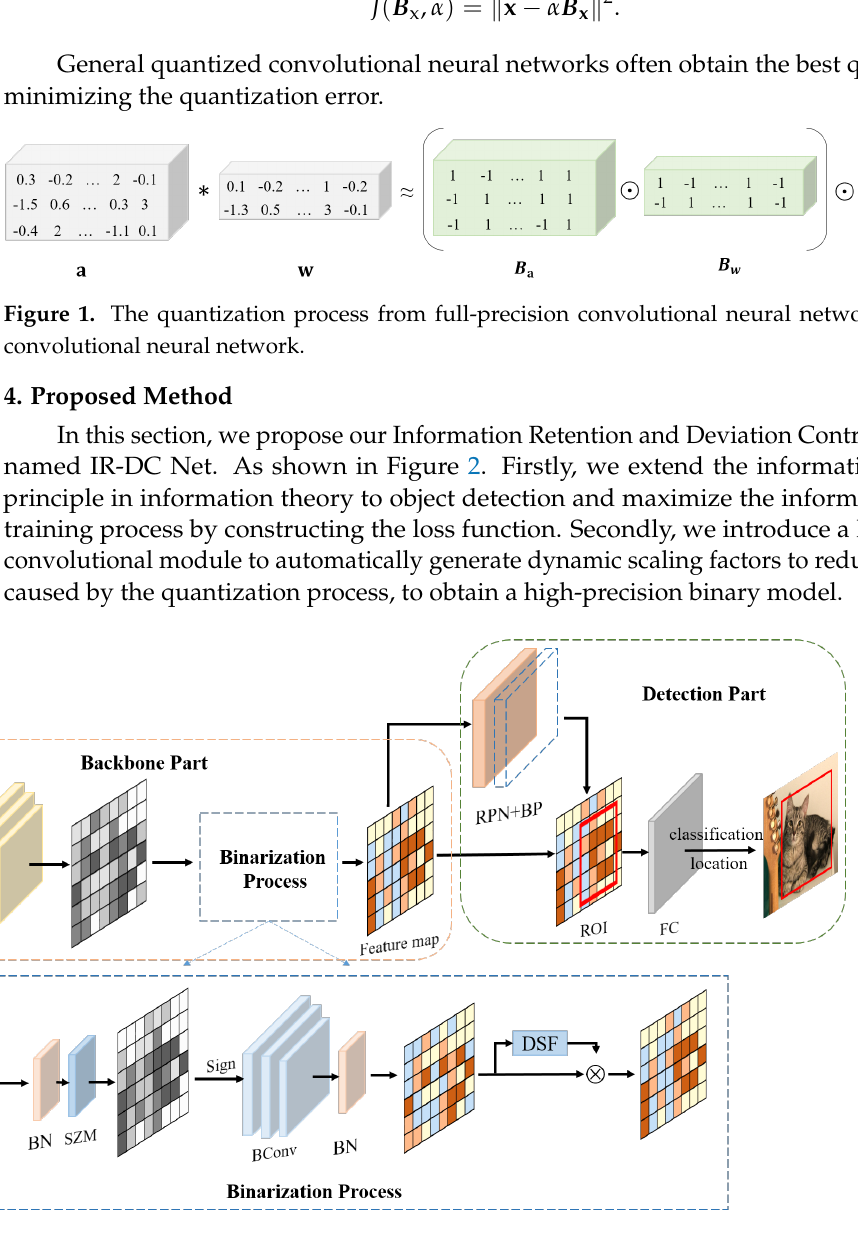
Figure 2. The object detector based on IR-DC net is composed of a backbone part and a detection part. We binarize the backbone part and the Region Proposal Networks (RPN) of the detection part. The Standard Zero Mean (SZM) maximizes the information entropy of the network, and the Dynamic Scale Factor (DSF) reduces the error between the binary parameter and the real